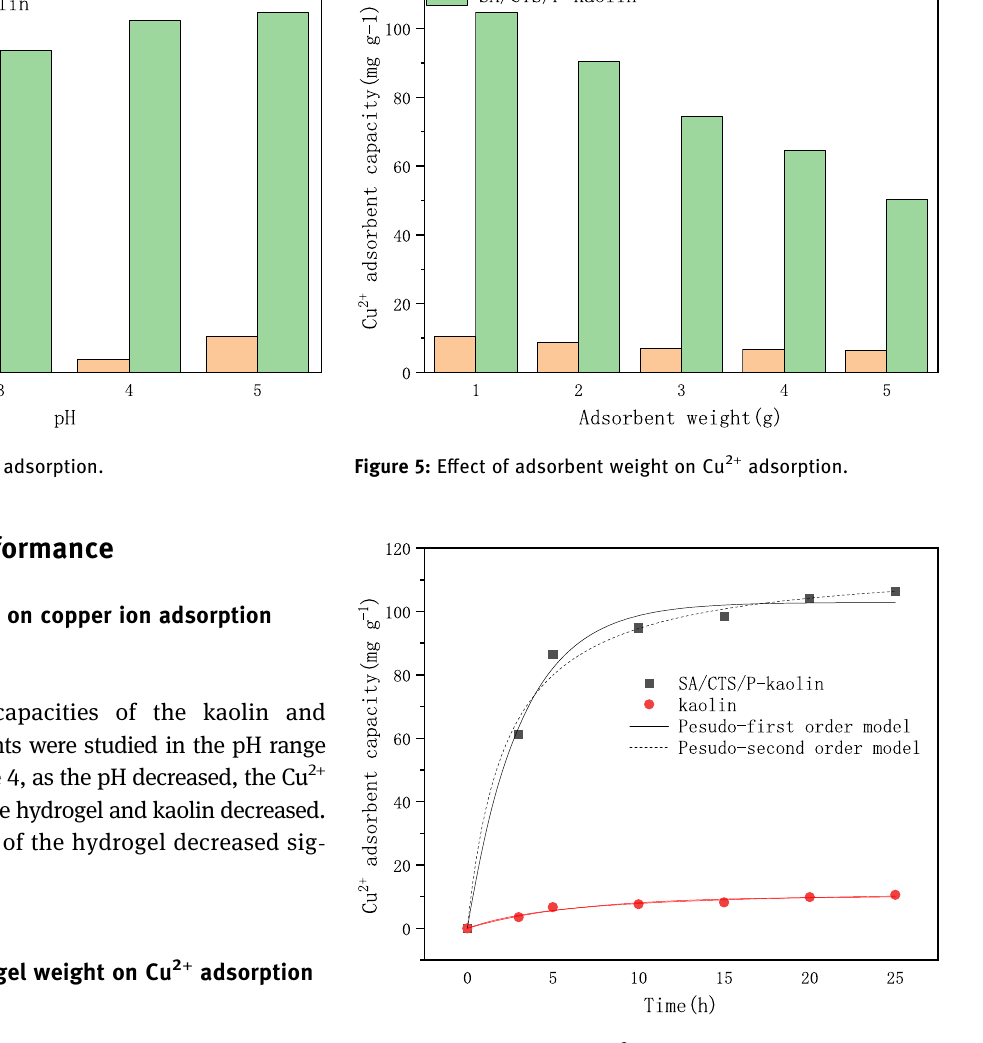
Figure 6: Kinetic models of Cu 2 + removal by SA/CTS/P - kaolin and kaolin